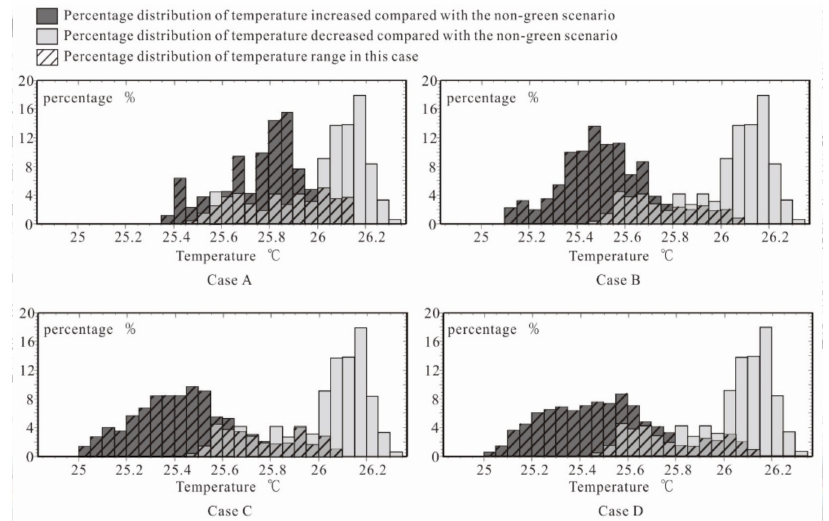
Figure 7. Percentages distribution of temperatures range in residential district at pedestrian height on 23 June at 14:00.